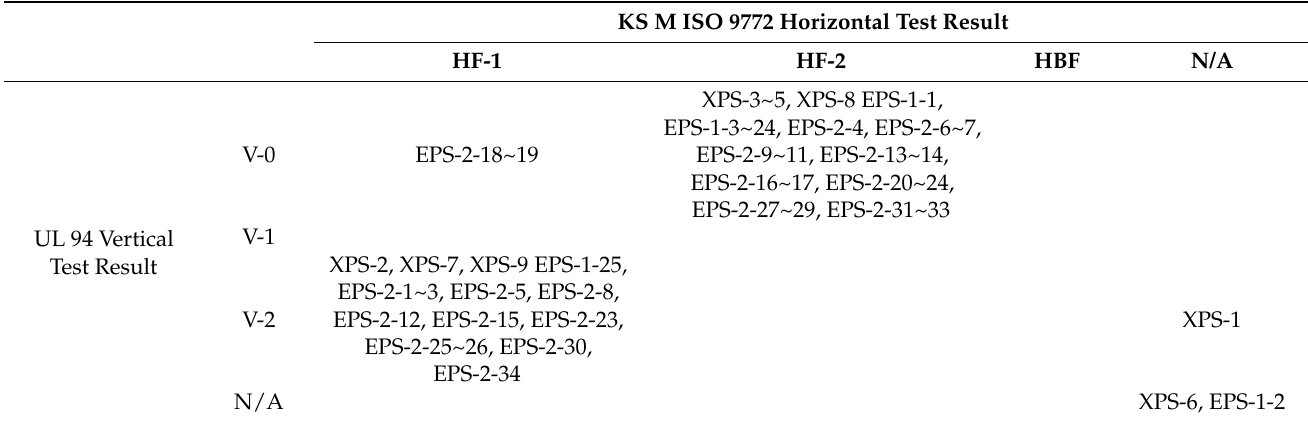
Table 3. Burning test results in the horizontal and vertical directions on the samples of XPS and EPS Type 1 and 2.